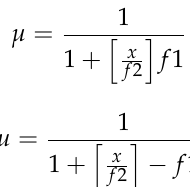
Table 8. Fuzzy set memberships function with controls points used for natural aquifer recharge.